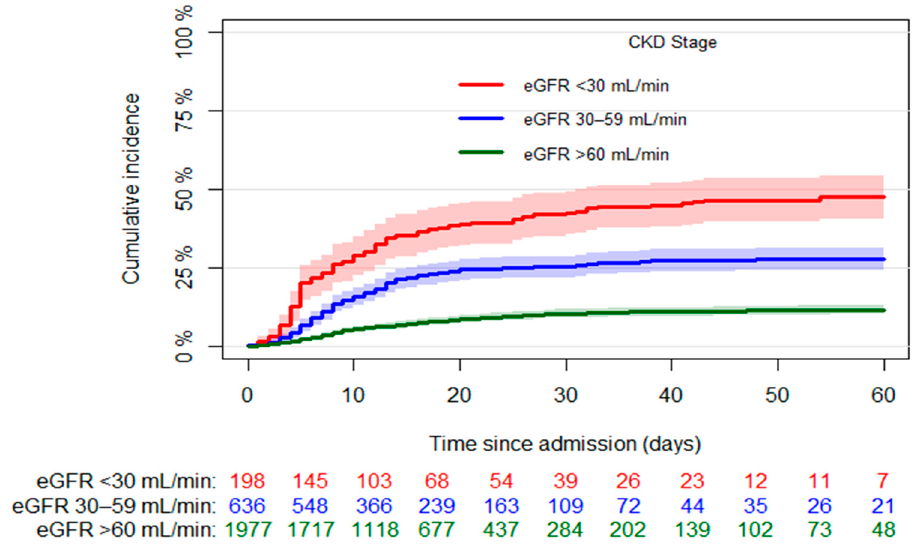
Figure 1. Crude in ‐ hospital mortality stratified by CKD, with number of patients at risk in three groups. Abbreviations: CKD, chronic kidney disease; eGFR, estimated glomerular filtration